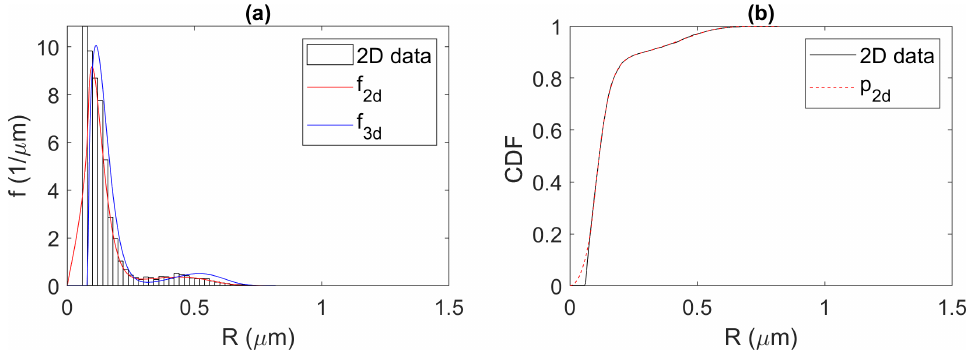
Figure 6. ( a ) Comparison of the measured 2D data with the approximated 2D and 3D particle size distribution functions. The histogram presents the data, whilst the red and blue continuous lines describe the calculated 2D and 3D distribution functions. ( b ) The cumulative distribution functions comparing the 2D data and the 2D model, with the data described using the continuous black line, and the calculation in the dashed red